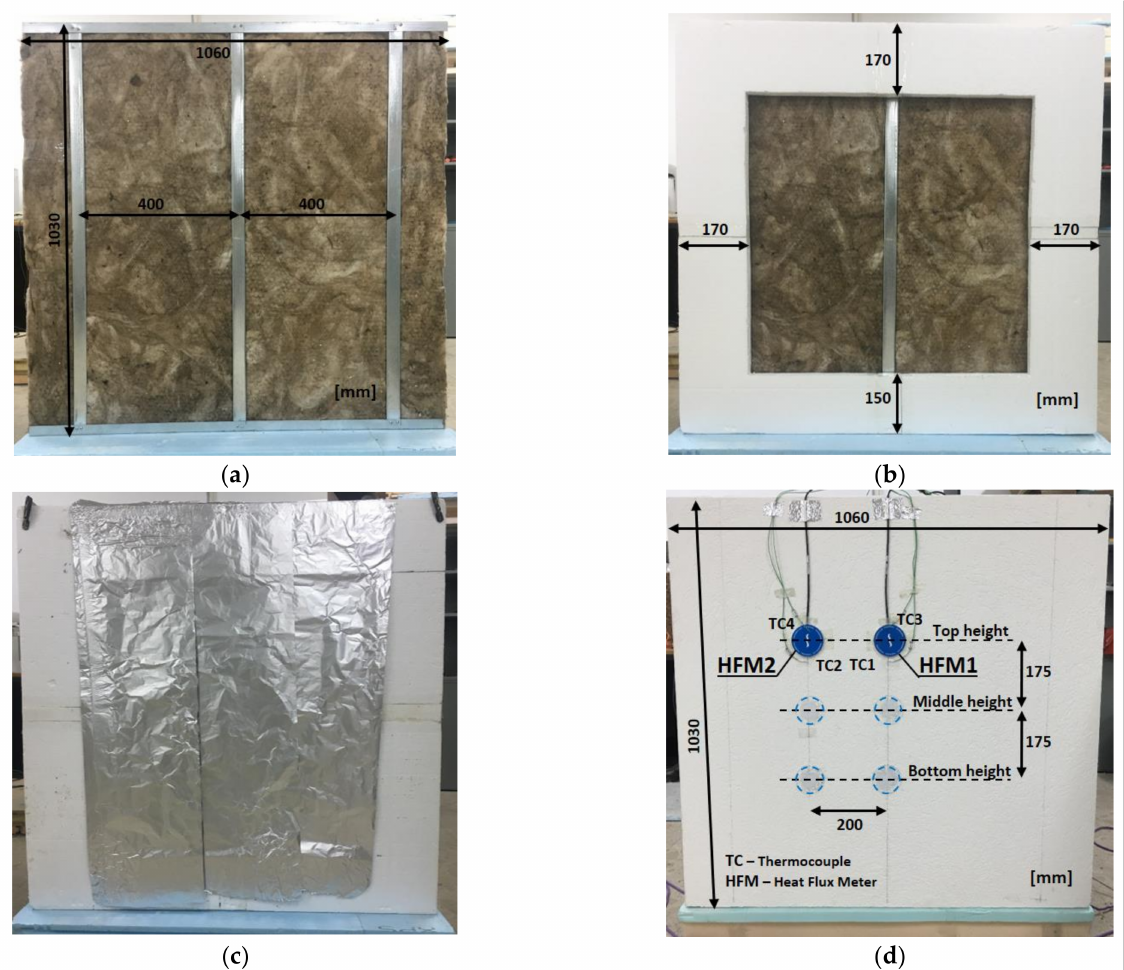
Figure 3. Double pane LSF wall test sample. ( a ) Hot LSF wall pane; ( b ) EPS perimeter frame; ( c ) Aluminium reflective foil; ( d ) Sensors (cold